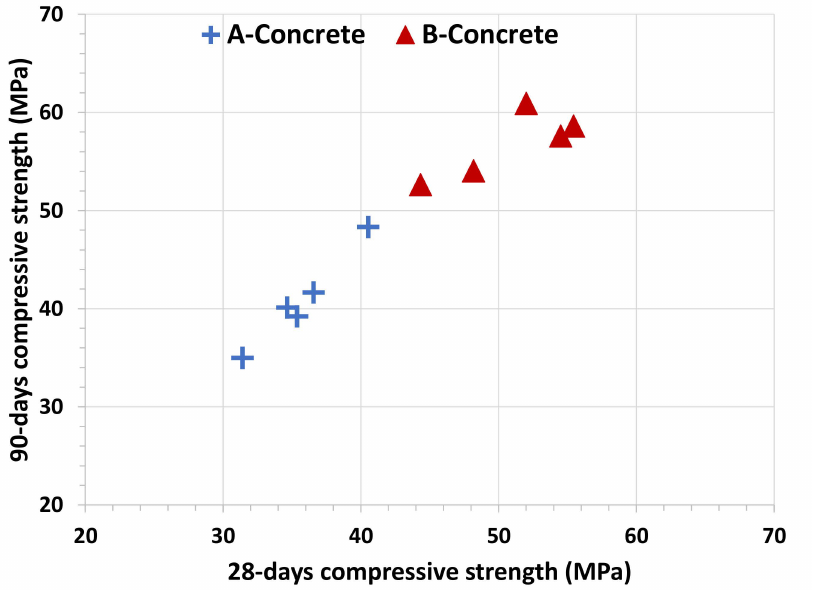
Figure 4. 28-days versus 90-days compressive strength (MPa)